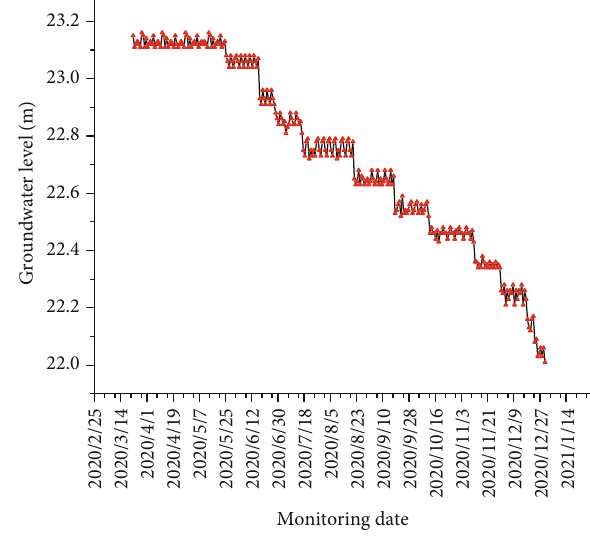
Figure. 13: Water level monitoring diagram.